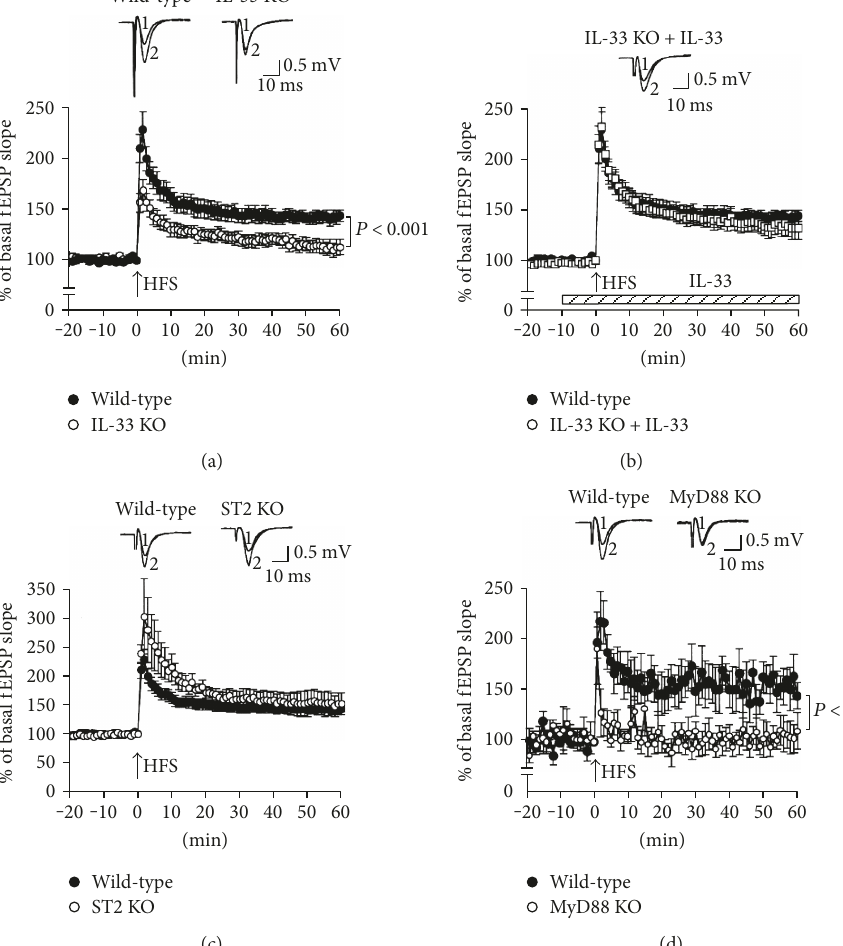
Figure 2: Scha ff er collateral/CA1 LTP. fEPSPs were monitored in the CA1 region of hippocampal slices from wild-type mice (wild-type), IL- 33-de fi cient mice (IL-33 KO) in the absence and presence of IL-33 (1 ng/mL) (a, b), ST2-de fi cient mice (ST2 KO) (c), and MyD88-de fi cient mice (MyD88 KO) (d) before and after HFS. In the graphs, each point represents the mean ( ± SEM) percentage of basal EPSP slope (0 min) ( n =6 – 13 independent experiments). P values, ANOVA followed by Fisher ’ s PLSD